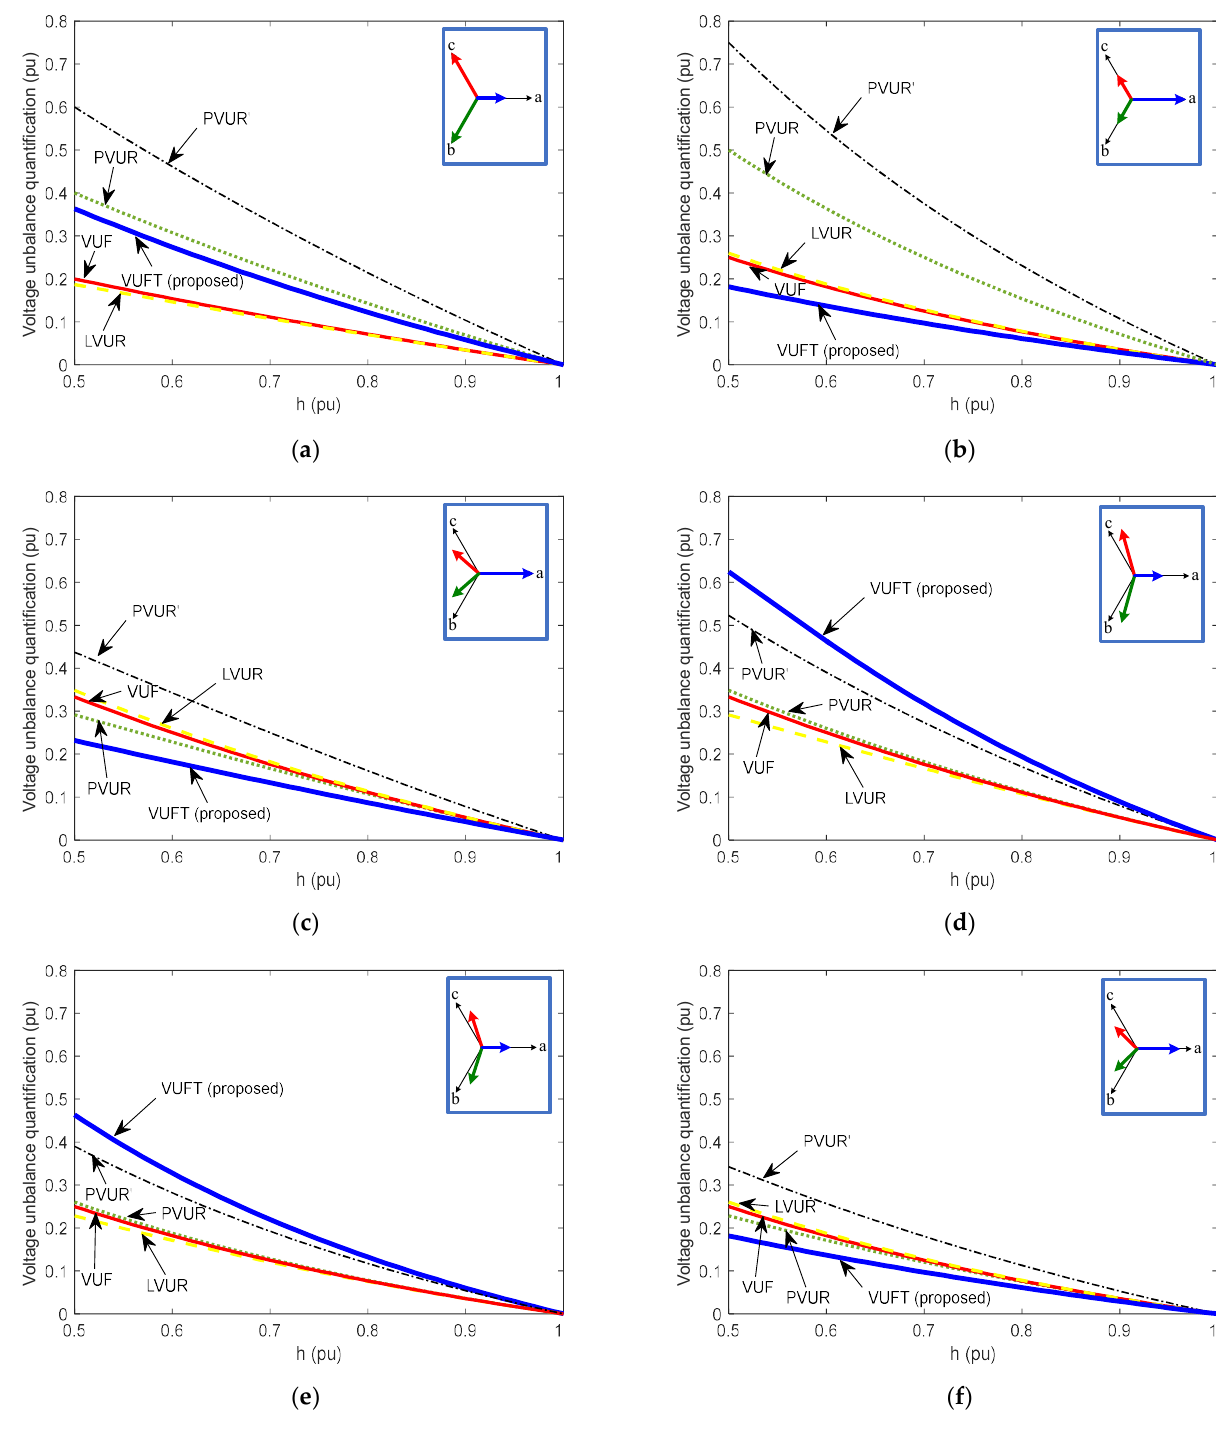
Figure 9. Voltage unbalance quantification (in per unit) by means of the proposed factor (VUFT) and the existing factors in the literature (VUF, LVUR, PVUR and PVUR’). ( a – f ) Unbalance voltage scenarios (whose voltage phasors are shown in each subplot). h = remaining voltage with respect to rated voltage (1 = no voltage drop; 0.5 = 50% voltage drop). Legend: solid thick line = VUFT (proposed); solid thin line = VUF; dashed line = LVUR; dotted line = PVUR; dashed-dotted line = PVUR’.